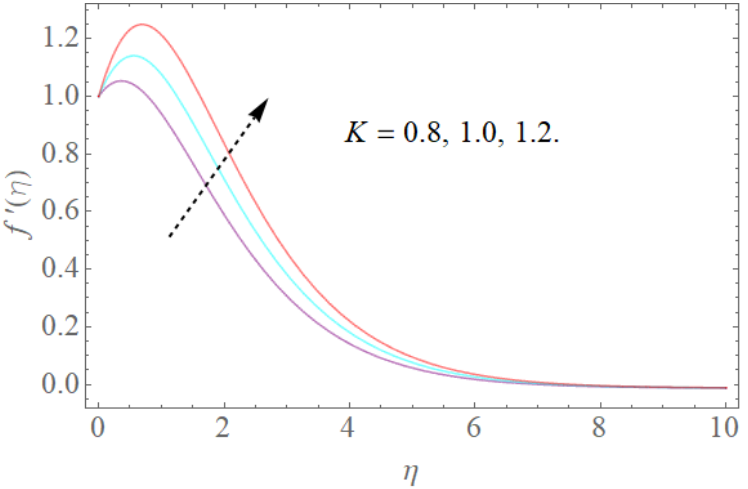
(cid:48) ( η ) when β = 1.0, k   f  = 1.2, R = 0.4, N r = 2.0, λ =   f  1 b when  Figure 4. The effect of K on f when